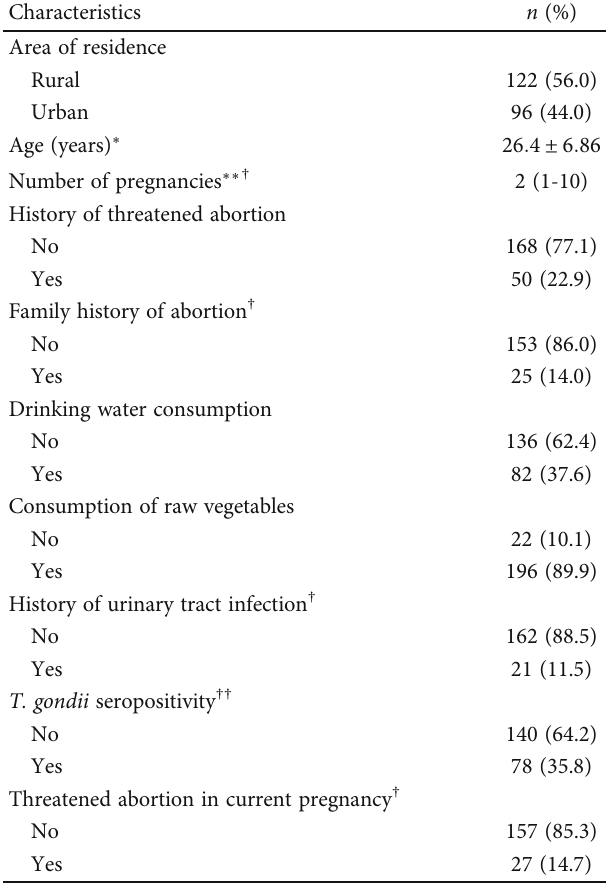
Table 1: Characteristics of pregnant women attended in a hospital in Lambayeque,